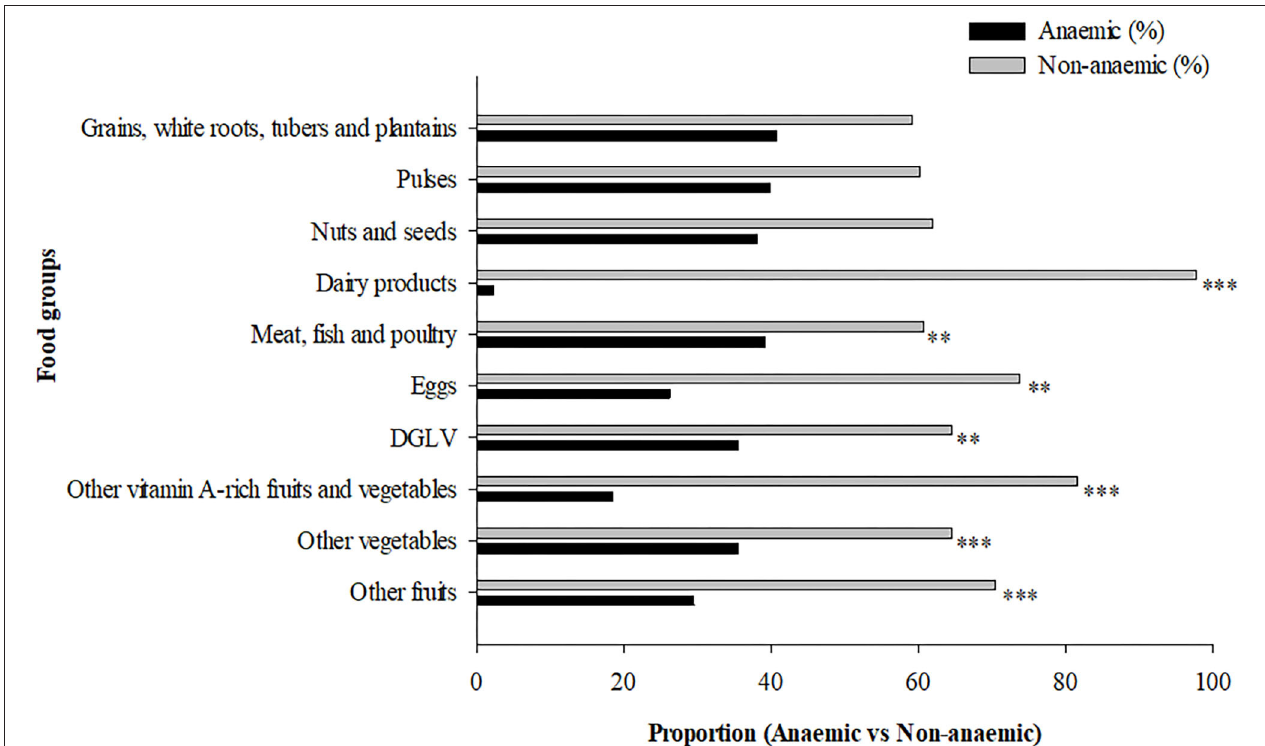
FIGURE 2 | Maternal dietary diversity during pregnancy and anemia status. ** P < 0.01, *** P < 0.001, Pearson Chi-square test. DGLV, dark green leafy vegetable.